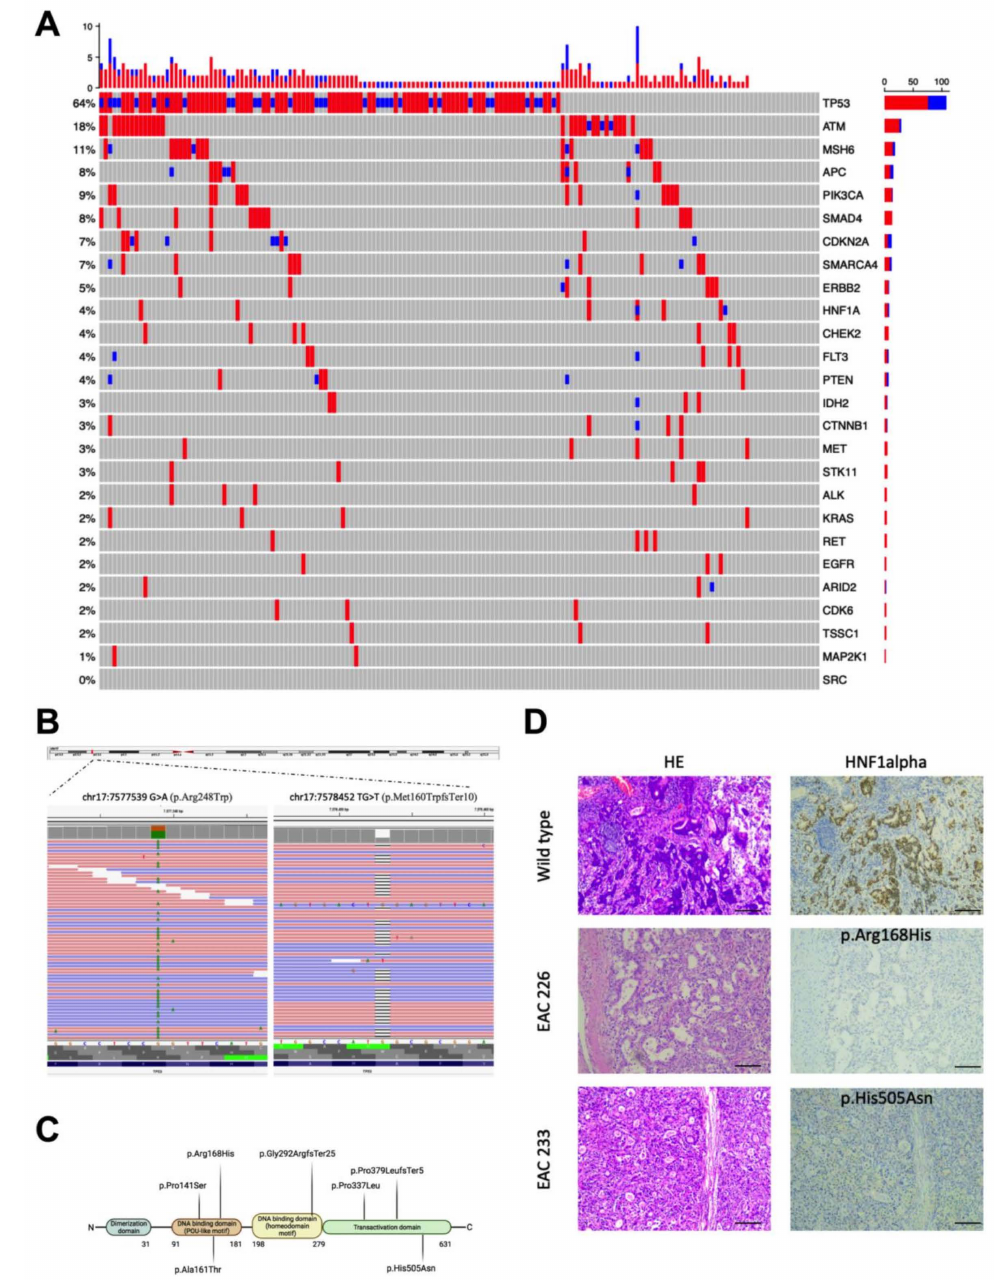
Figure 1. Gene variants identified in 164 EAC cases. ( A ) Variants identified in the EAC cohort; in red “missense”; in blue “LOF (frameshift and stop codon)”. ( B ) Representation of two TP53 mutations (visualized using Integrative Genomic Viewer, IGV): a missense (p.Arg248Trp) and a frameshift (p.Met160TrpfsTer10). The display shows individual forward (F) sequence reads in red and reverse (R) reads in blue. Selected positions are covered by a high number of aligned sequenced reads and both mutations can be seen in approximately half of the F and R reads. ( C ) Mutations in the HNF1alpha gene were identified in the EAC samples and mapped to the different protein domains. ( D ) Examples of the immunohistochemical patterns observed in a control sample (i.e., no HNF1alpha mutations) vs. cases carrying different alterations in the HNF1alpha gene. In particular, we showed the expression pattern in two cases with the HNF1alpha p.Arg168His variant or the p.His505Asn; the decreased staining suggested that the misfolded proteins might be degraded. Scale bar 500 µ